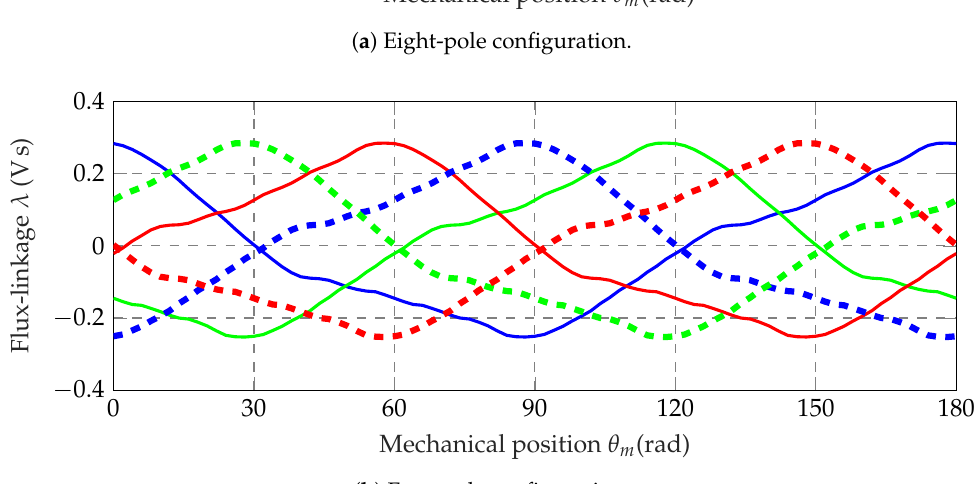
( b ) Four-pole configuration. Figure 14. No-load flux linkage Figure 14. No-load flux linkage waveform. Figure 14. No-load flux linkage waveform.